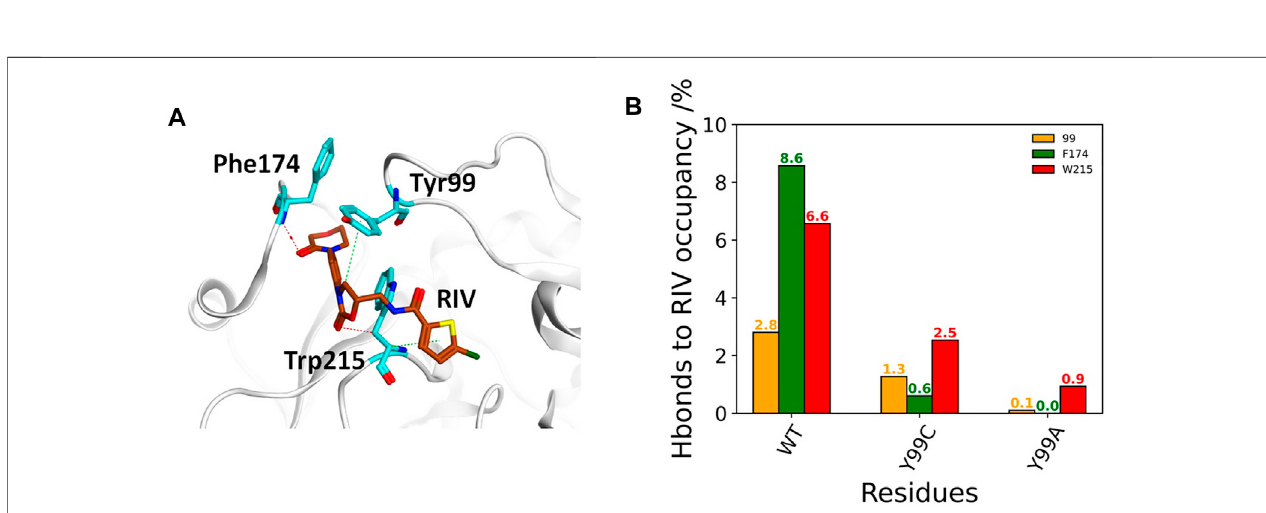
FIGURE 4 | Comparison of FX residue hydrogen-bonding with RIV in WT, Y99C, and Y99A mutant. (A) Illustration of the H-bonding (red dash) and H- π interaction (green dash) of RIV with the key residues in the S4 pocket of the wild-type system, where RIV has the carbon atoms colored in brown while those of the residues were colored in cyan. (B) Different H-bonding occupancies of the three key residues Y/C/A99 (in orange), F174 (in green), and W215 (in red) with RIV.